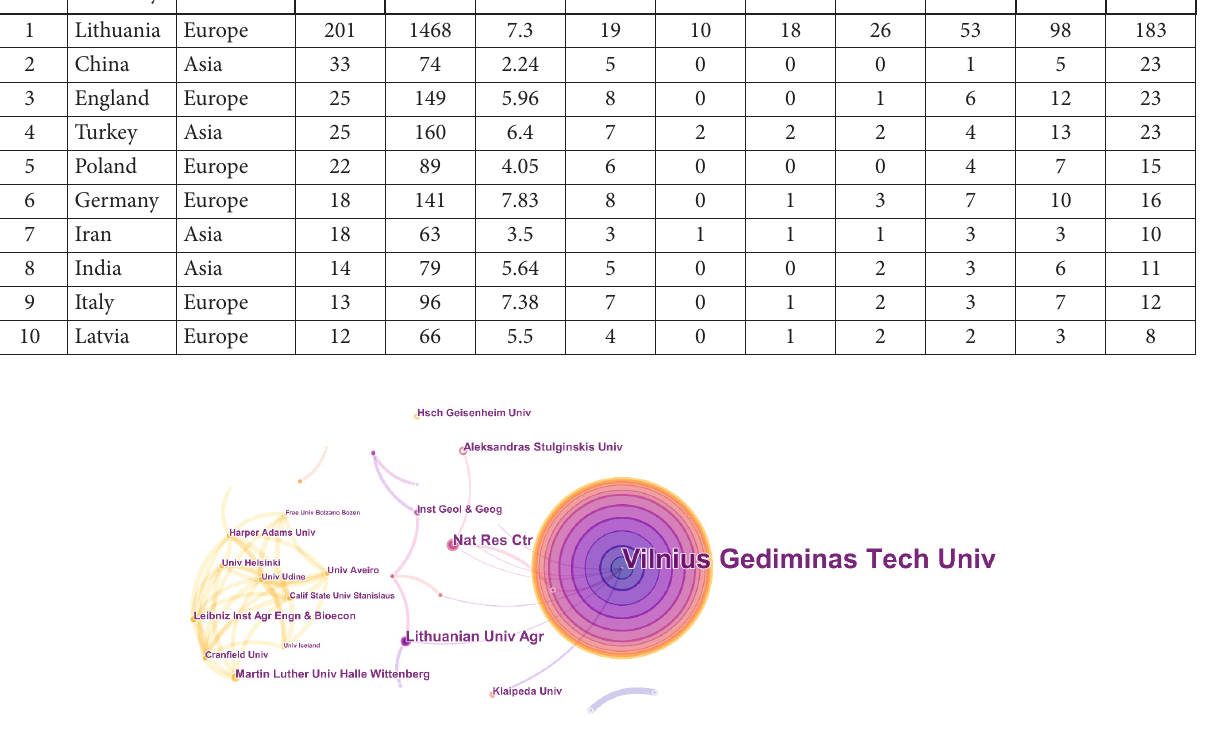
Figure 5. A visualization of the institution collaboration